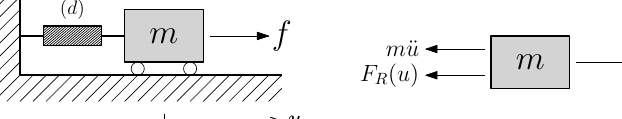
Figure 2. Sketch of the single degree of freedom (SDOF) system. The nonlinear device is denoted with letter ( d ). On the right-hand side the dynamic forces acting on the mass are reported: m ¨ u is the inertia force, F R is the restoring force of the device, which depends on its elongation u , f is the applied force.